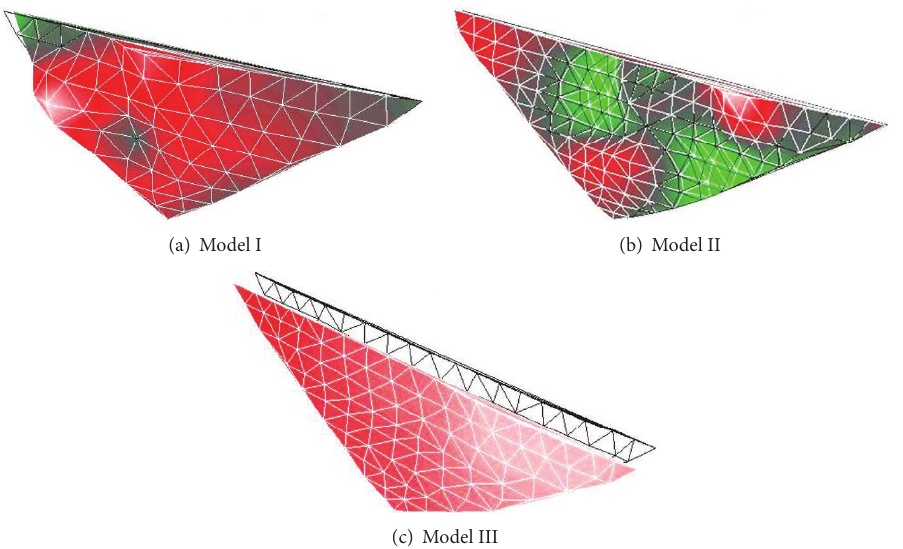
Figure 4: ODSs at base excitation of 100 Hz in contrast to initial static shape (plain mesh).